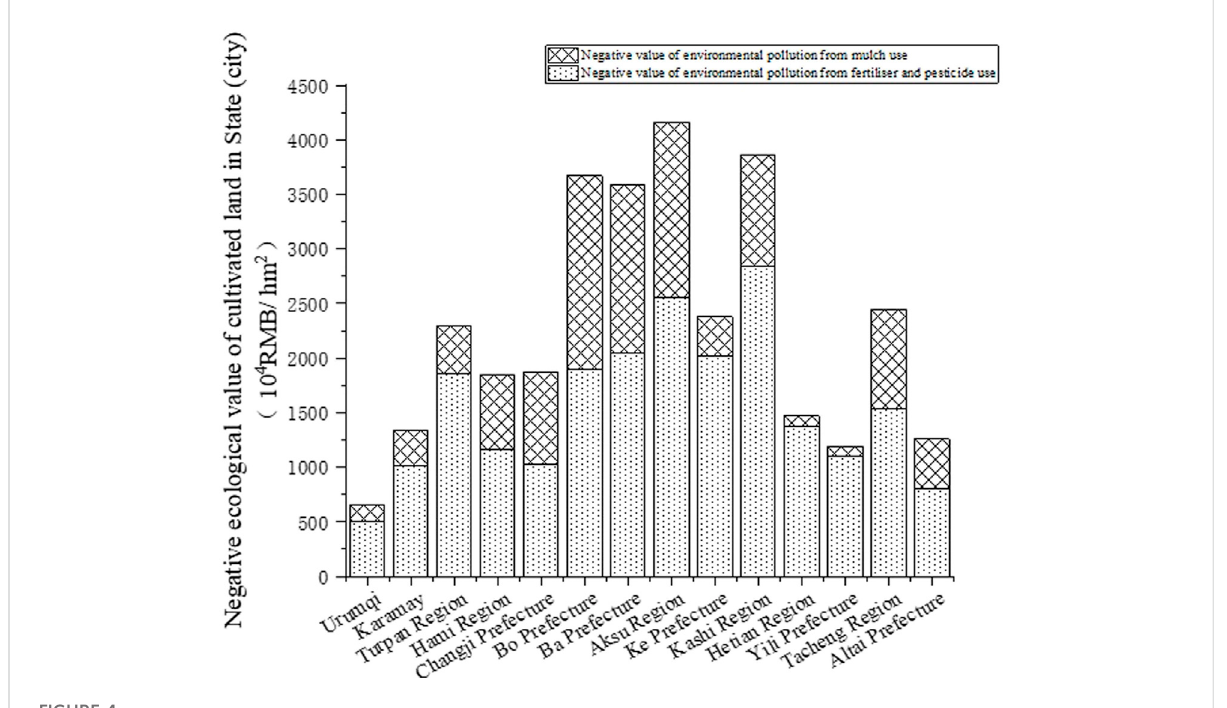
FIGURE 4 Negative ecological value of cultivated land in the state (city).